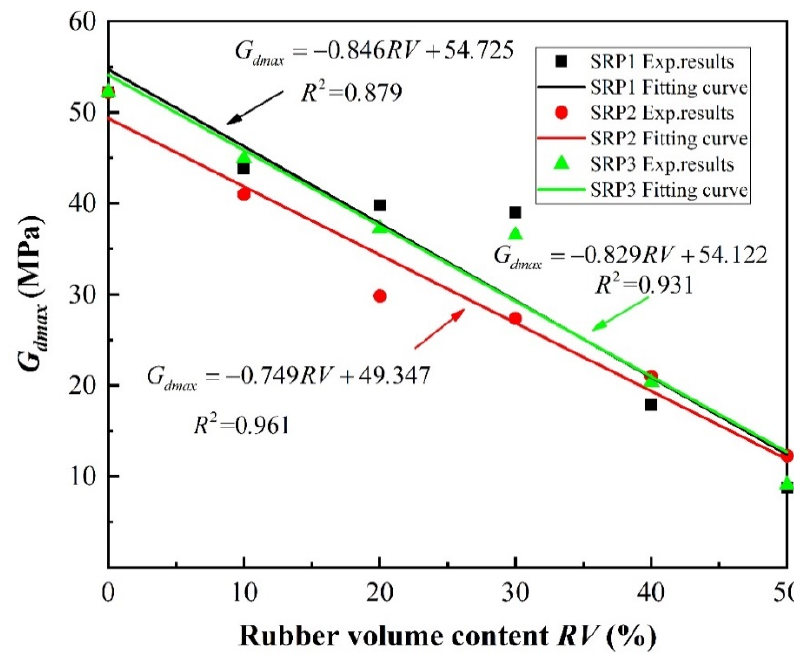
Figure 16. Effect of rubber content on the maximum dynamic shear moduli ( G dmax ) of sand–rubber mixture specimens under 100 kPa confining pressure.